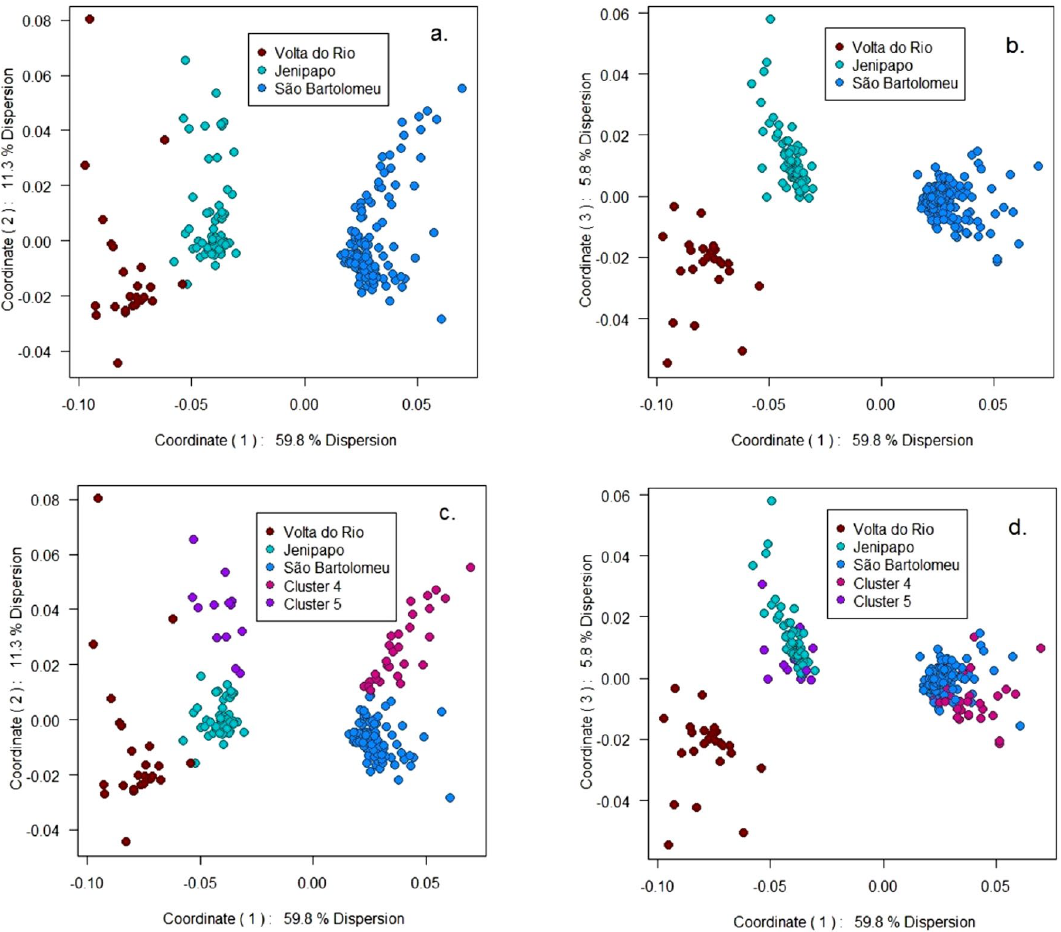
Figure 2. Principal Coordinates of Genetic Distance Matrix. ( a ) PC1 versus PC2 with infrapopulations color coded according to community sampled. ( b ) PC1 versus PC3 with the same coding as in ( a ). ( c ) PC1 versus PC2 with infrapopulations color coded according to cluster analysis results with K = 5 . ( d ) PC1 versus PC3 with the same coding as in ( c